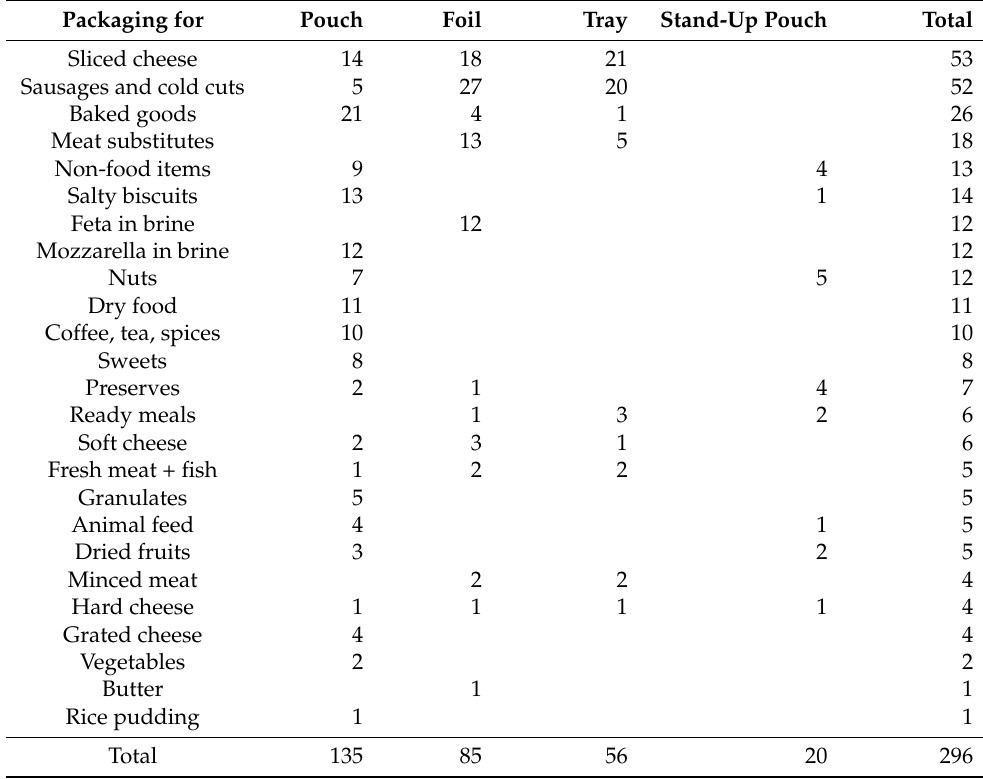
Table 6. Examined packaging within the ML